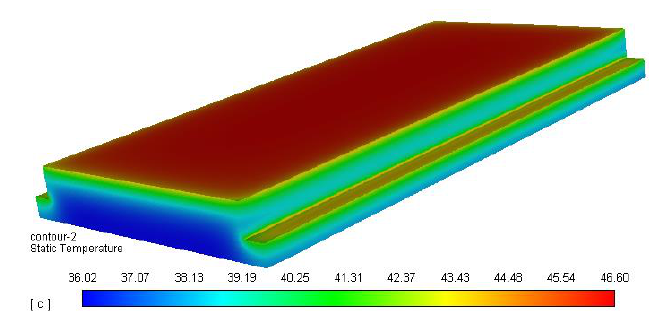
Figure 3. Simulation results of the ballastless track temperature (12:00). Figure 4 is a three-dimensional diagram of temperature changes inside the slab track during the daytime. It can be seen that there was a negative temperature gradient inside the slab track at 6:00. The temperature gradient inside the slab track was the smallest at 8:00. After 8:00, the surface temperature of the slab track rose rapidly, and the interior of the slab track showed a positive temperature gradient. The surface temperature of the slab track formed an obvious peak at 14:00. Overall, the slab track surface temperature varia- tion is greater than the internal temperature variation. Figure 4. Diagram of simulation results of temperature variation with time at different depths dur- ing the daytime. To carry out the deformation simulation of the slab track, it was necessary to fit the internal temperature field of the slab track. The temperature distribution at each time point in the daytime of the slab track in mid-August was calculated, and the results are shown in Figure 5.